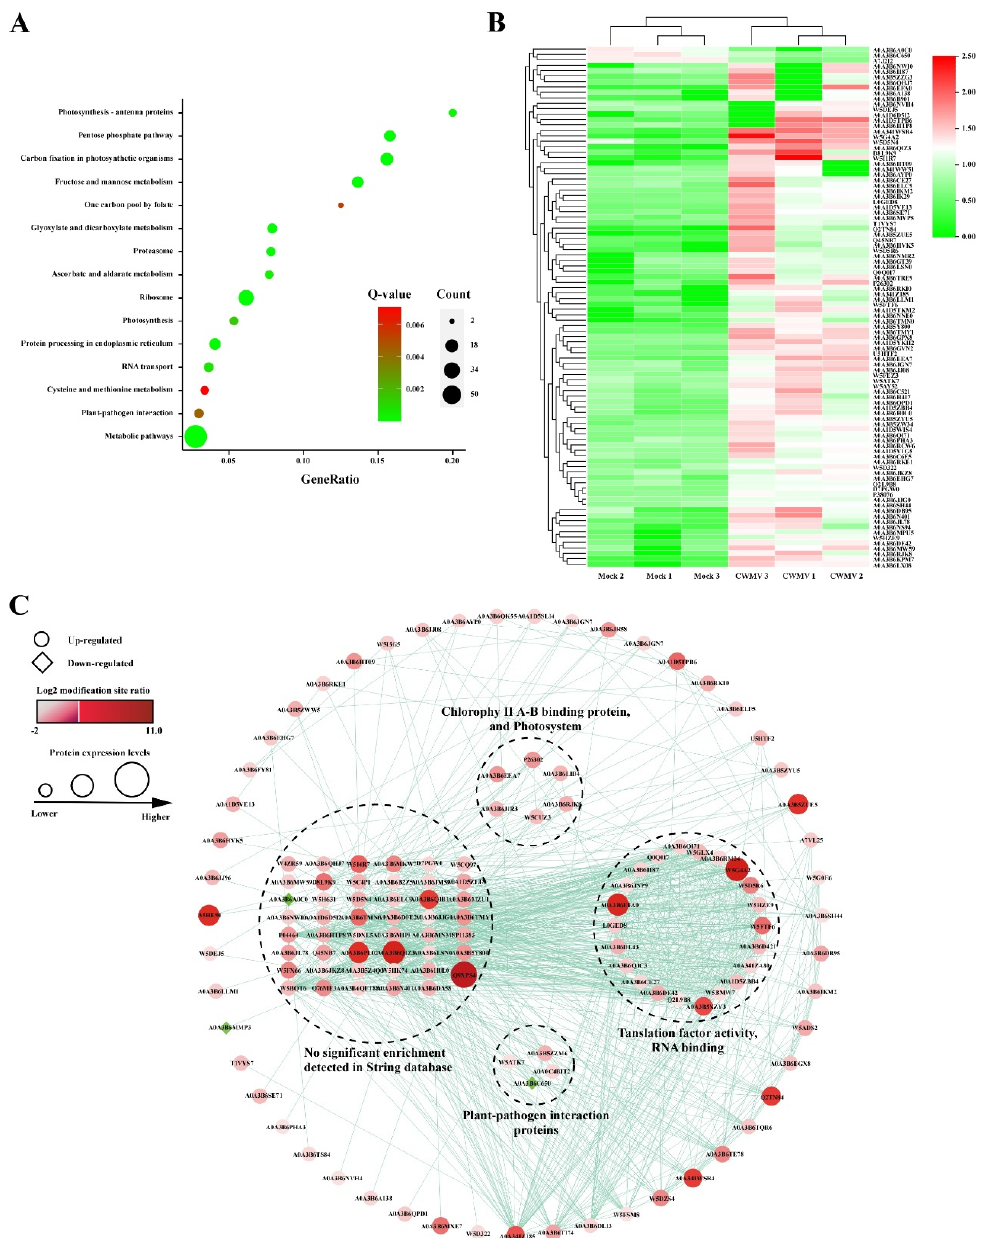
Figure 5. KEGG pathway and interaction network analyses of the differentially expressed ubiqui- tinated proteins in CWMV-infected wheat. ( A ) KEGG pathway enrichment analysis of the differentially expressed ubiquitinated proteins. The Rich factor indicated the ratio of the differentially expressed ubiquitinated protein numbers annotated in this pathway term to all gene numbers annotated in this pathway term. The Q-value is the corrected p -value, ranging from 0 to 1, with lower values suggesting greater intensiveness. The circles represent the number of enriched genes, with the larger circles indicating more enriched genes. ( B ) Heatmap shows hierarchical clustering of significantly differentially expressed genes, which enriched plant–pathogen interaction, response to stress, and response to hormone pathways. The relative protein abundance was normalized by Z-score standard- ization. ( C ) Interaction networks for all the identified differentially expressed ubiquitinated proteins in CWMV-infected